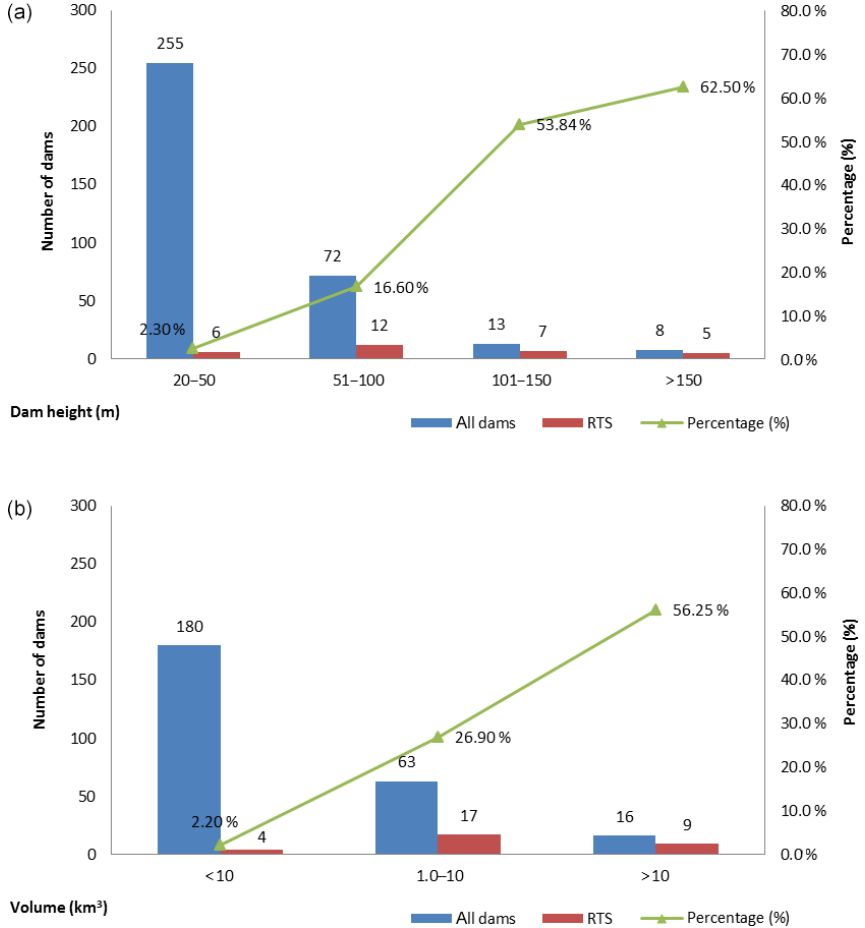
Figure 11. Percentage of cases of reservoir-triggered seismicity as stated by (a) dam height and (b) reservoir volume. A total of 54% of